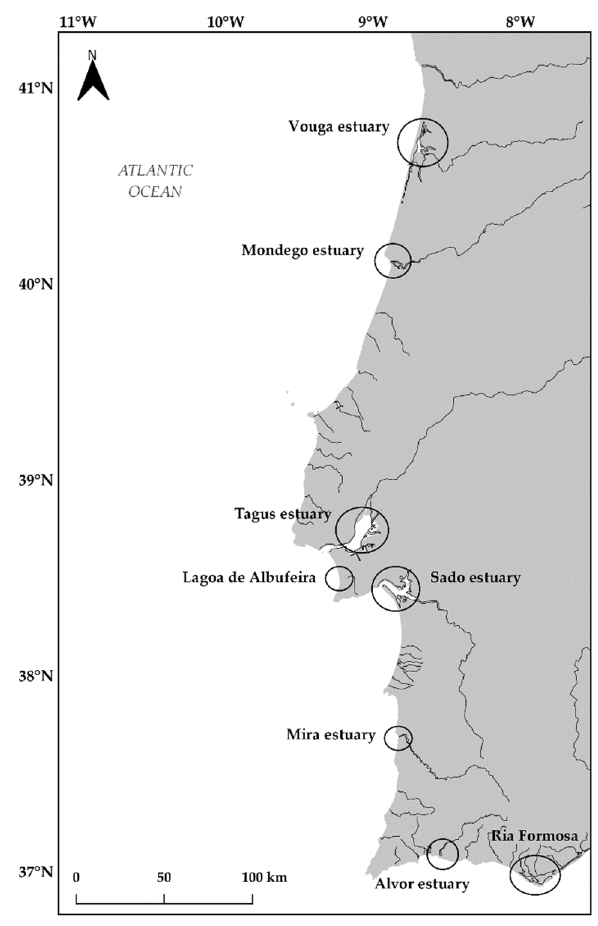
Figure 3. Main sites for aquaculture production in continental Portugal—circles mark the main sites for production in coastal systems.